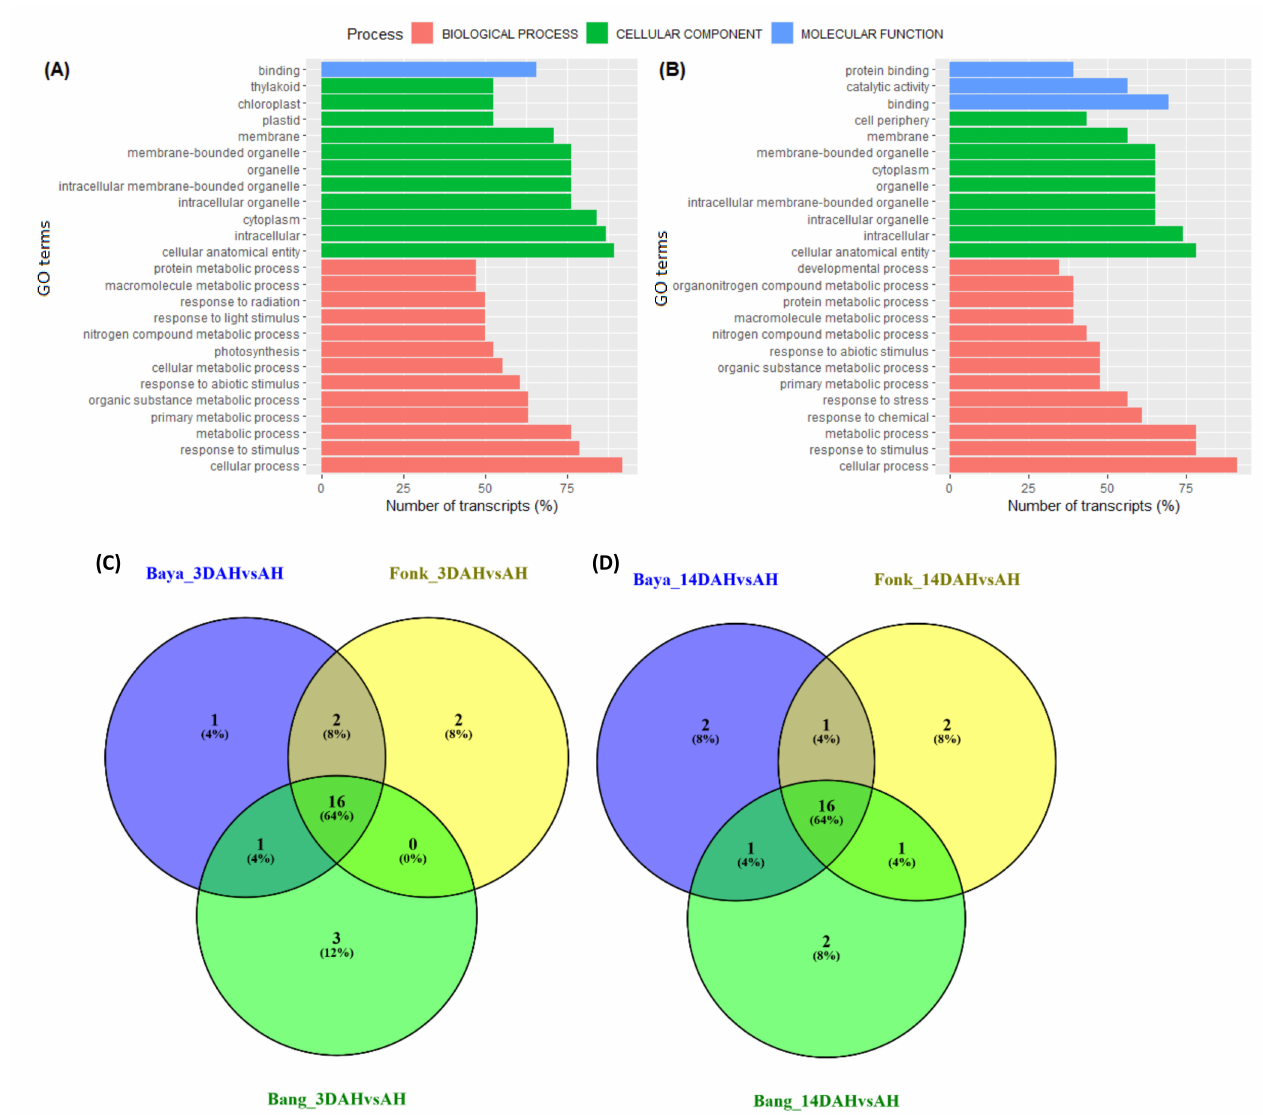
Figure 4. Functional annotation of the top up-regulated enriched gene ontology (GO) terms of D. dumetorum tubers after harvest (AH, 3DAH, 14DAH). ( A , B ) the top 25 up-regulated enriched GO terms of the combined analysis of three hardening accessions 3DAH and 14DAH, respectively. ( C , D ) Venn diagrams of the enrichment of the top 20 GO terms of each hardened accession 3DAH and 14DAH, respectively. The blue bar represents a molecular process, the green bar represents the cellular component, and red bar represents the biological